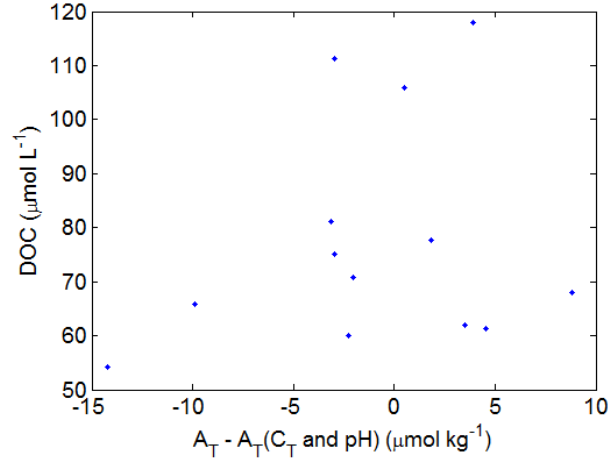
Figure 5. Dissolved organic carbon (DOC) and total alkalinity ( A T ) discrepancy (measured A T minus calculated A T from C T and pH T )